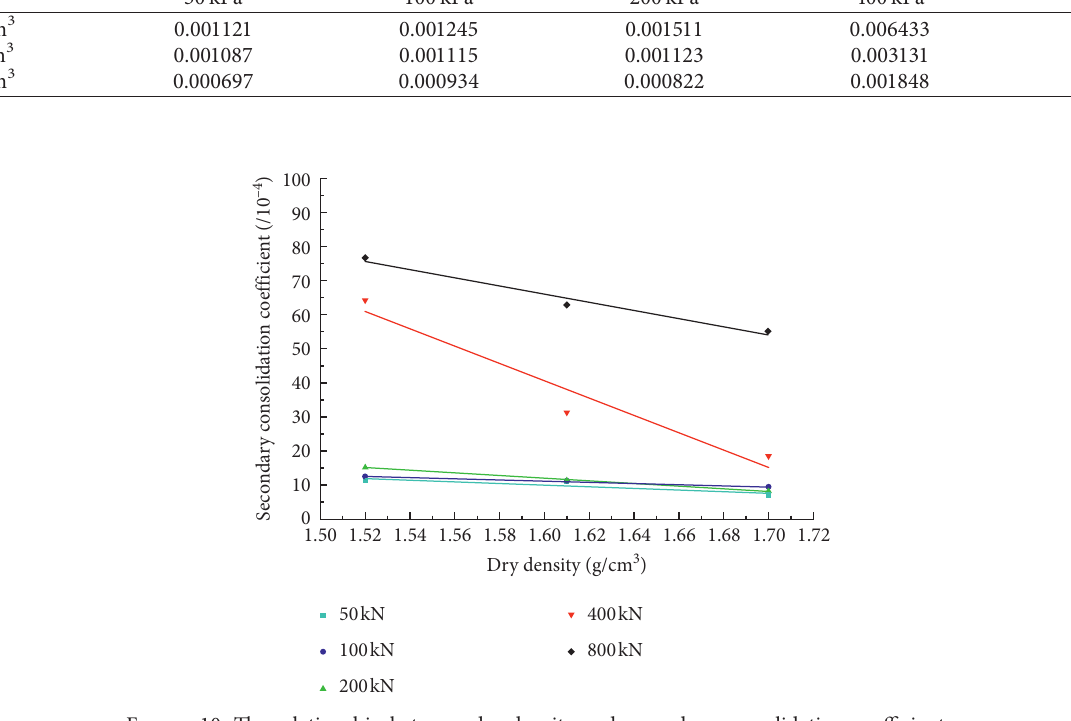
Figure 9: Consolidation test curves of expansive soil under different dry density conditions. Table 9: Secondary consolidation coefficient table of expansive soil under different dry density conditions. Dry density